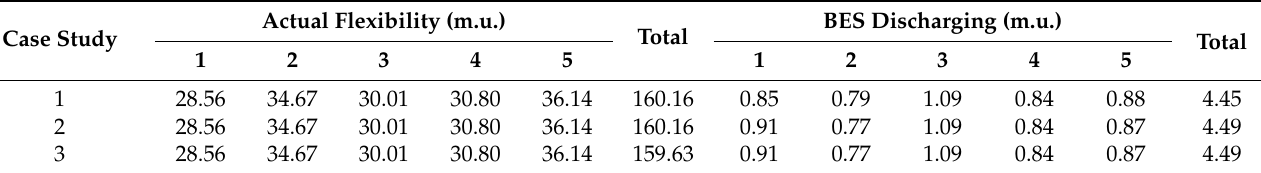
Table 8. Total remuneration according to the CTR method.